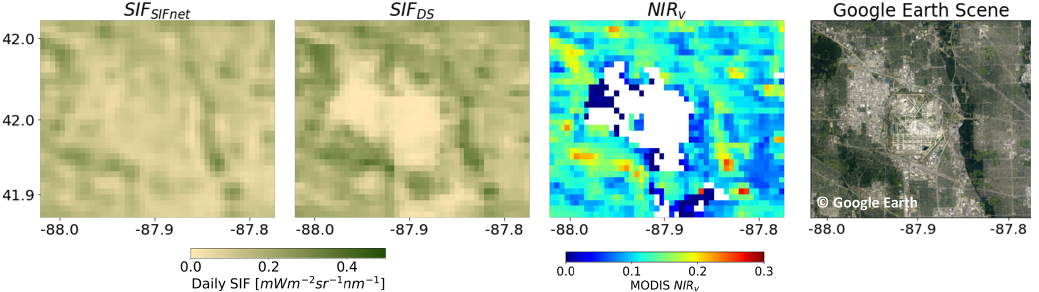
Figure 9. SIFnet SIF, downscaled SIF, MODIS NIR v , and a Google Earth cut-out for a part of Chicago. Left panel shows the SIFnet estimate, second panel shows the downscaled estimate from Turner et al. (2020), third panel shows MODIS NIR v for Chicago, and last panel shows the Google Earth cut-out (Google LLC, 2021). For panels 1–3 the average data for April 2018 until March 2021 is shown.